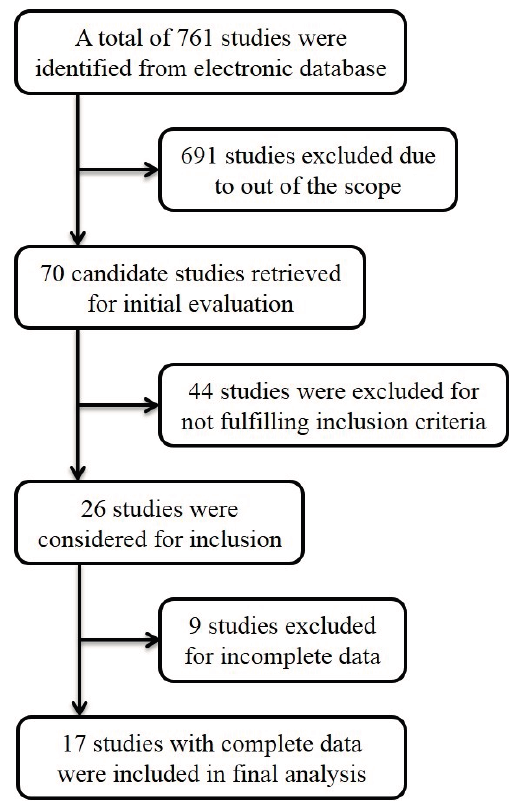
Figure 1. Flow diagram for selection of studies in the